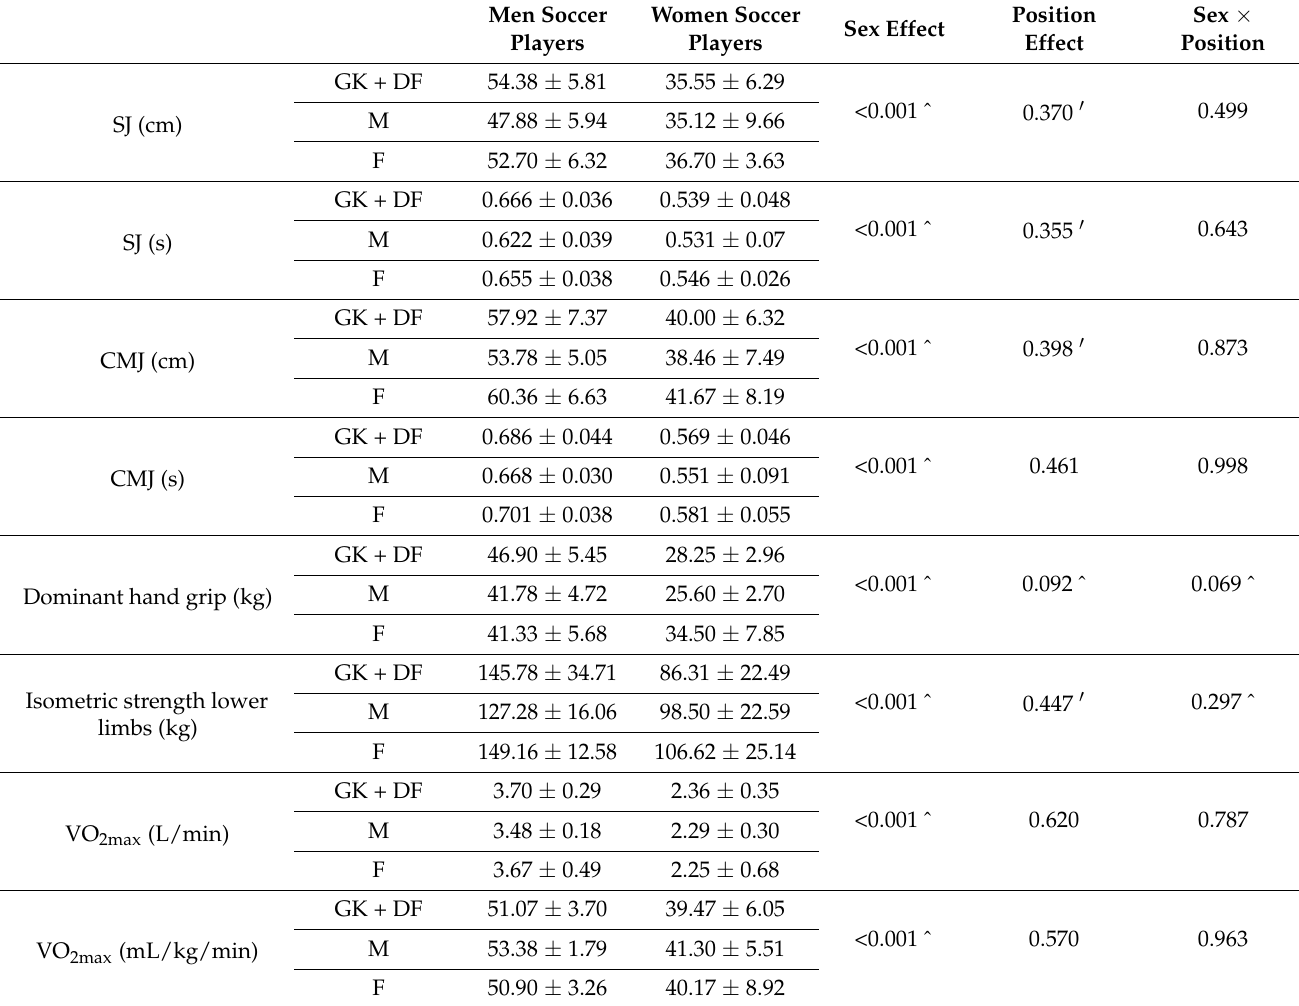
Table 3. Physical fitness according to sex and playing